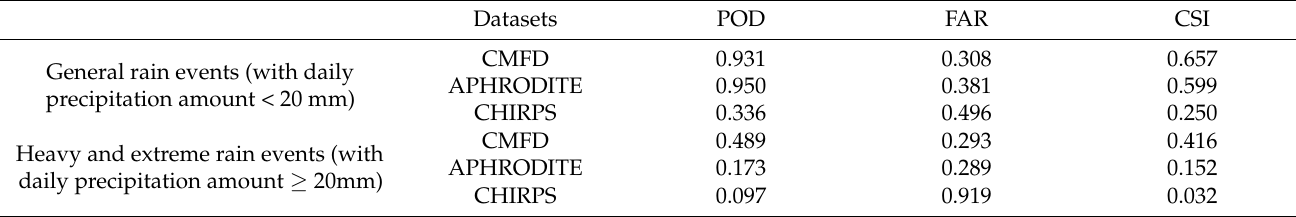
Table A3. Mean categorical verification statistics: POD, FAR and CSI for detecting different rain events derived from CMFD, APHRODITE, and CHIRPS for the period